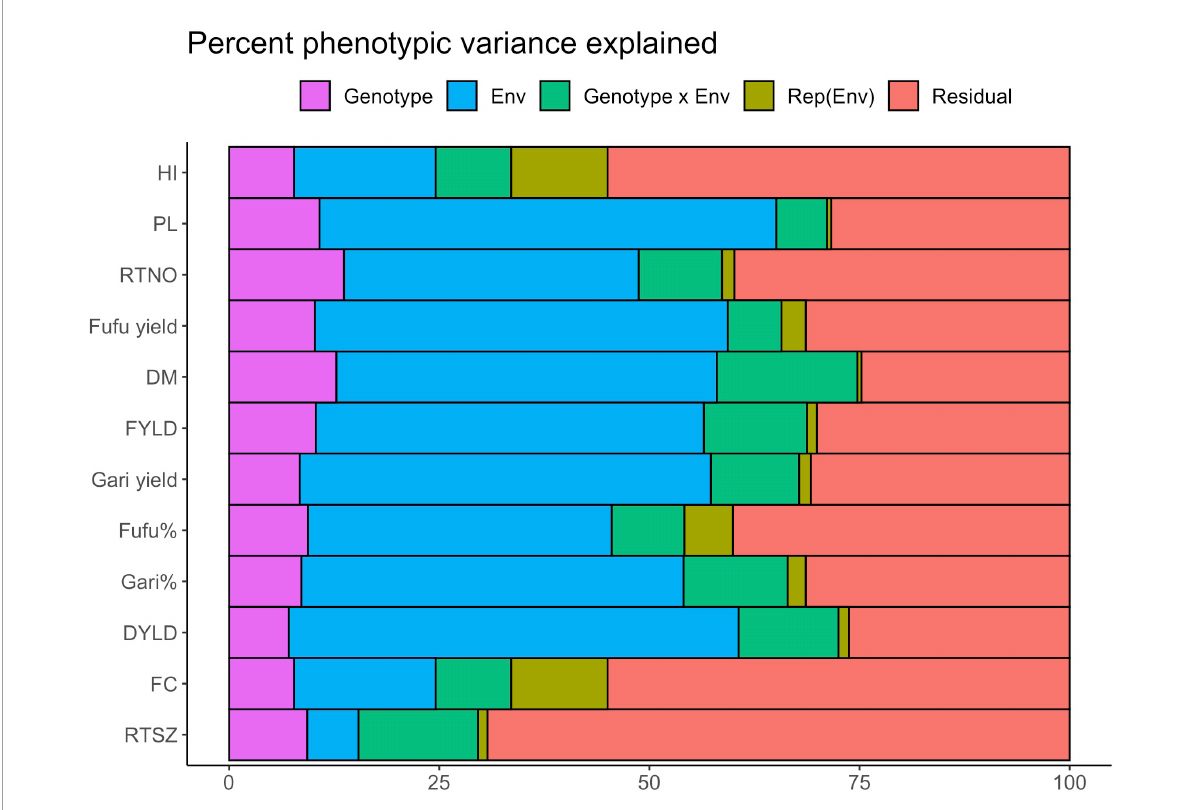
FIGURE5 Percent of phenotypic variance explained by each fixed model analysis of variance model for 12 processed product and yield related traits. Env, Environment; rep, Replication; DM, Drymatter; RTNO, Root number; DYLD, Dry root yield; FYLD, Fresh root yield; HI, Harvest index, RTSZ, Root